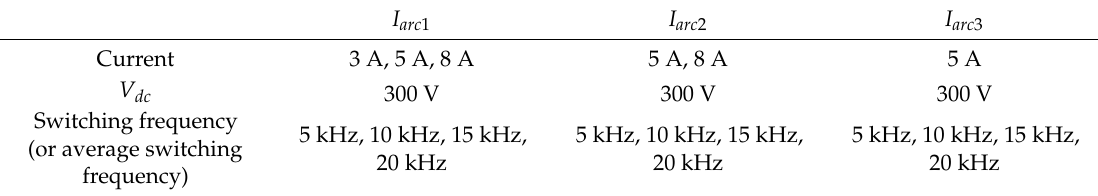
Table 3. Arc generation test conditions according to arc currents.